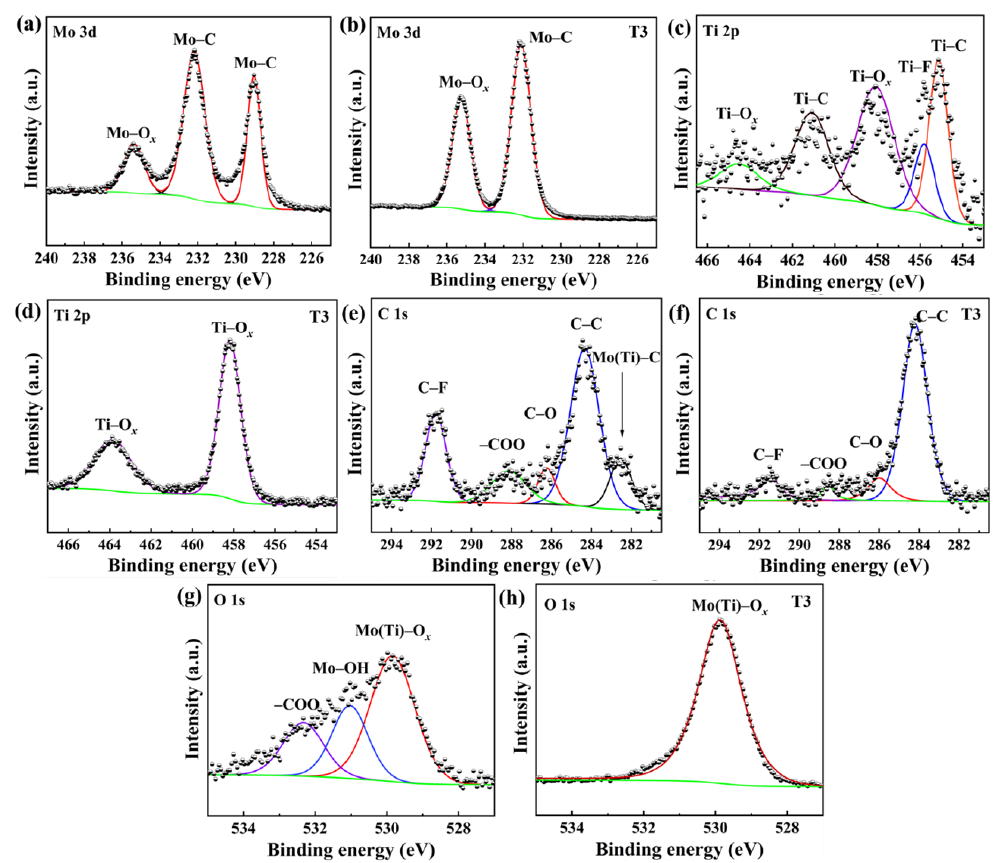
Fig. 4 Comparative XPS spectra between Mo 2 TiC 2 T x MXene and MoO 3 /TiO 2 /Mo 2 TiC 2 T x composites (T3): high-resolution (a, b) Mo 3d, (c, d) Ti 2p, (e, f) C 1s, and (g, h) O 1s